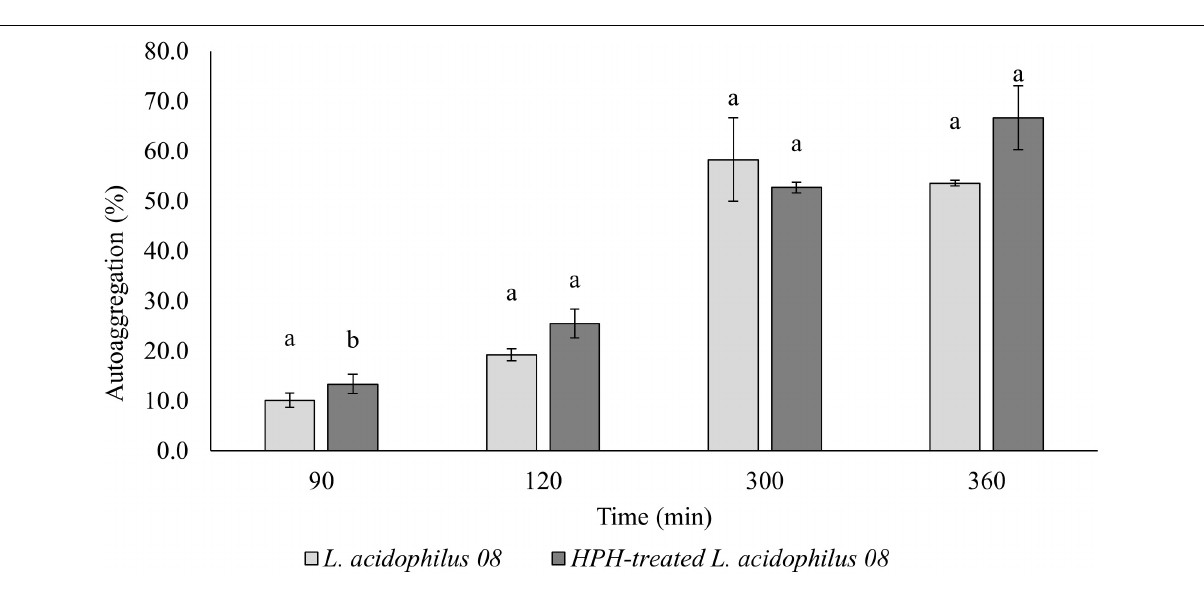
FIGURE 3 | Lactobacillus acidophilus 08 percentage autoaggregation values of the untreated (control) and treated (HPH-treated L. acidophilus 08) cells over time (90–360 min). Autoaggregation was calculated on the base of optical density (OD) at λ = 600 nm before and after incubation from HPH at 50 MPa treatments. The results are the average of three independent replicates ( n = 3). Error bars indicate the SD. Different lowercase letters indicate significant differences ( t -test; p < 0.05) for a considered sample during the frame time